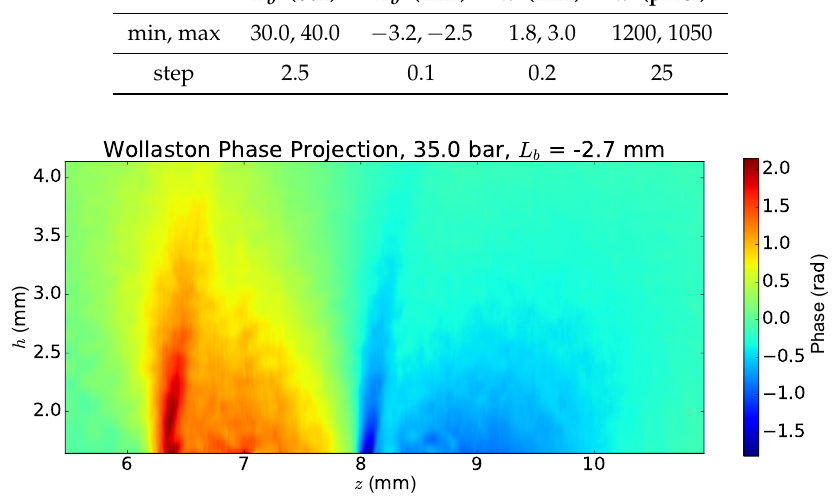
Figure 16. Typical Wollaston phase image of a shock front generated by a razor blade inserted from the left to a gas jet. Gas flow is directed